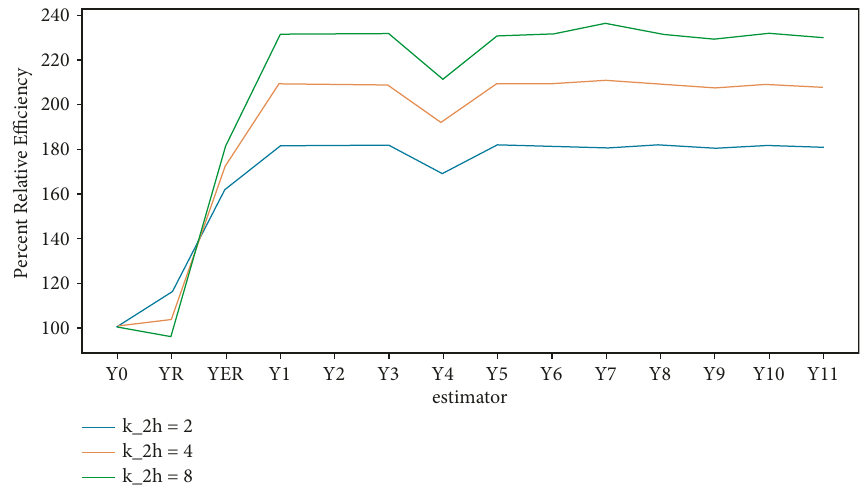
Figure 2: Plot of PREs at 20% nonresponse and 0.8 sensitivity level for population I.